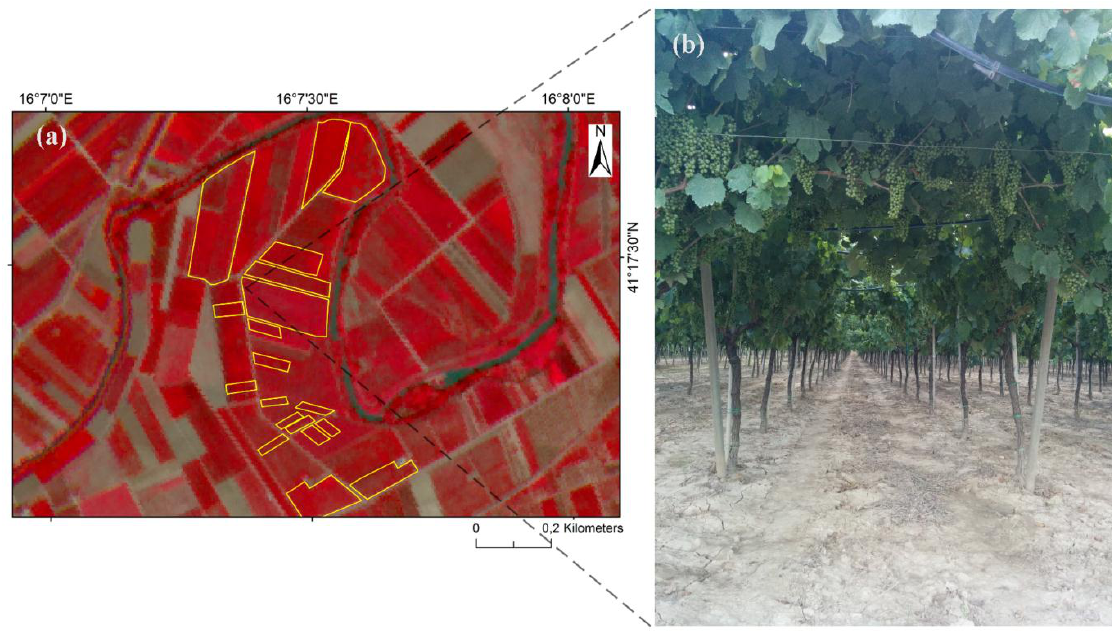
Figure 2. ( a ) Overall view of the vineyard study field displayed on a RapidEye image acquired on 2 August 2014 (infrared false color composition 532). Yellow borders show the experimental plots. ( b ) Canopy growth of the vineyard inter-row acquired on 24 July